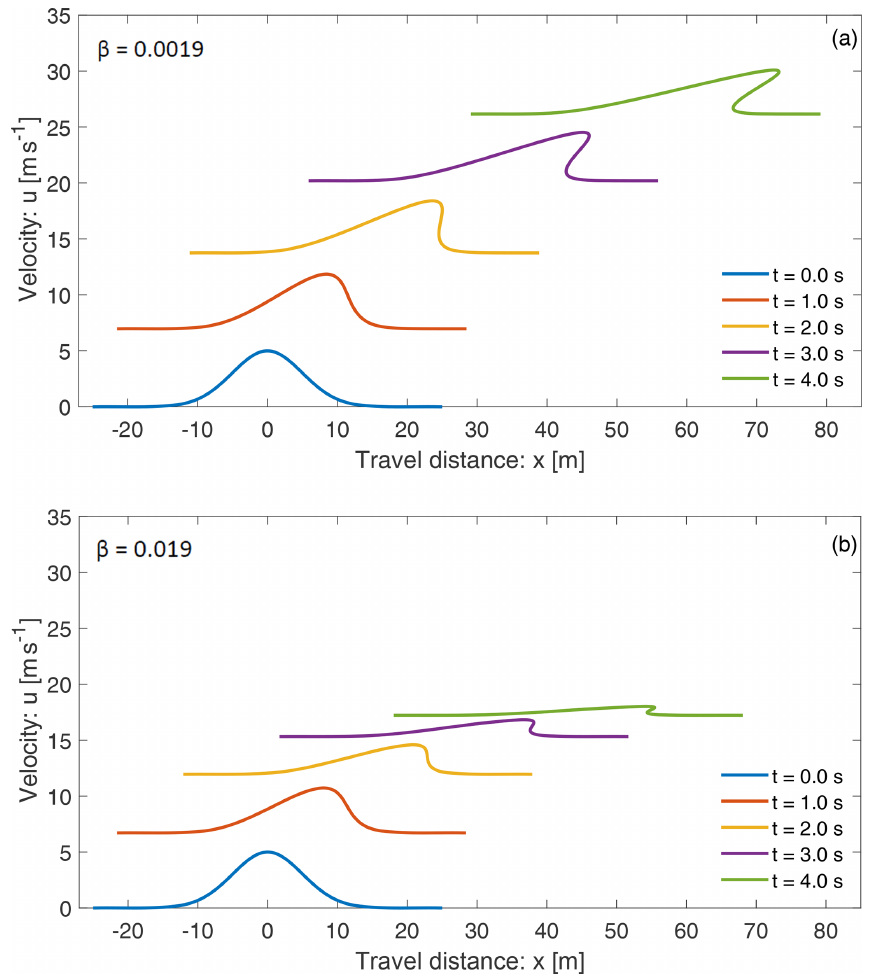
Figure 13. The breaking wave and folding as a landslide propagates down a slope. Panel (a) has lower drag, while panel (b) has higher drag, showing that drag strongly controls the wave breaking and folding as well as the magnitude of the landslide